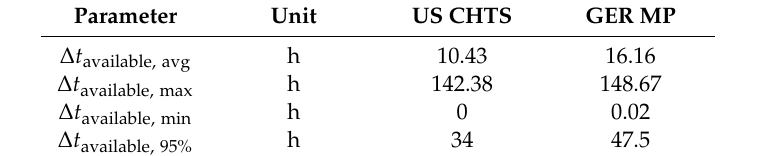
Figure 5. Distribution of the time period vehicles spend at home—sampled from all modeled vehicle availabilities. Table 3. Mean, maximum, minimum, and 95%-ile of time of availability at home.